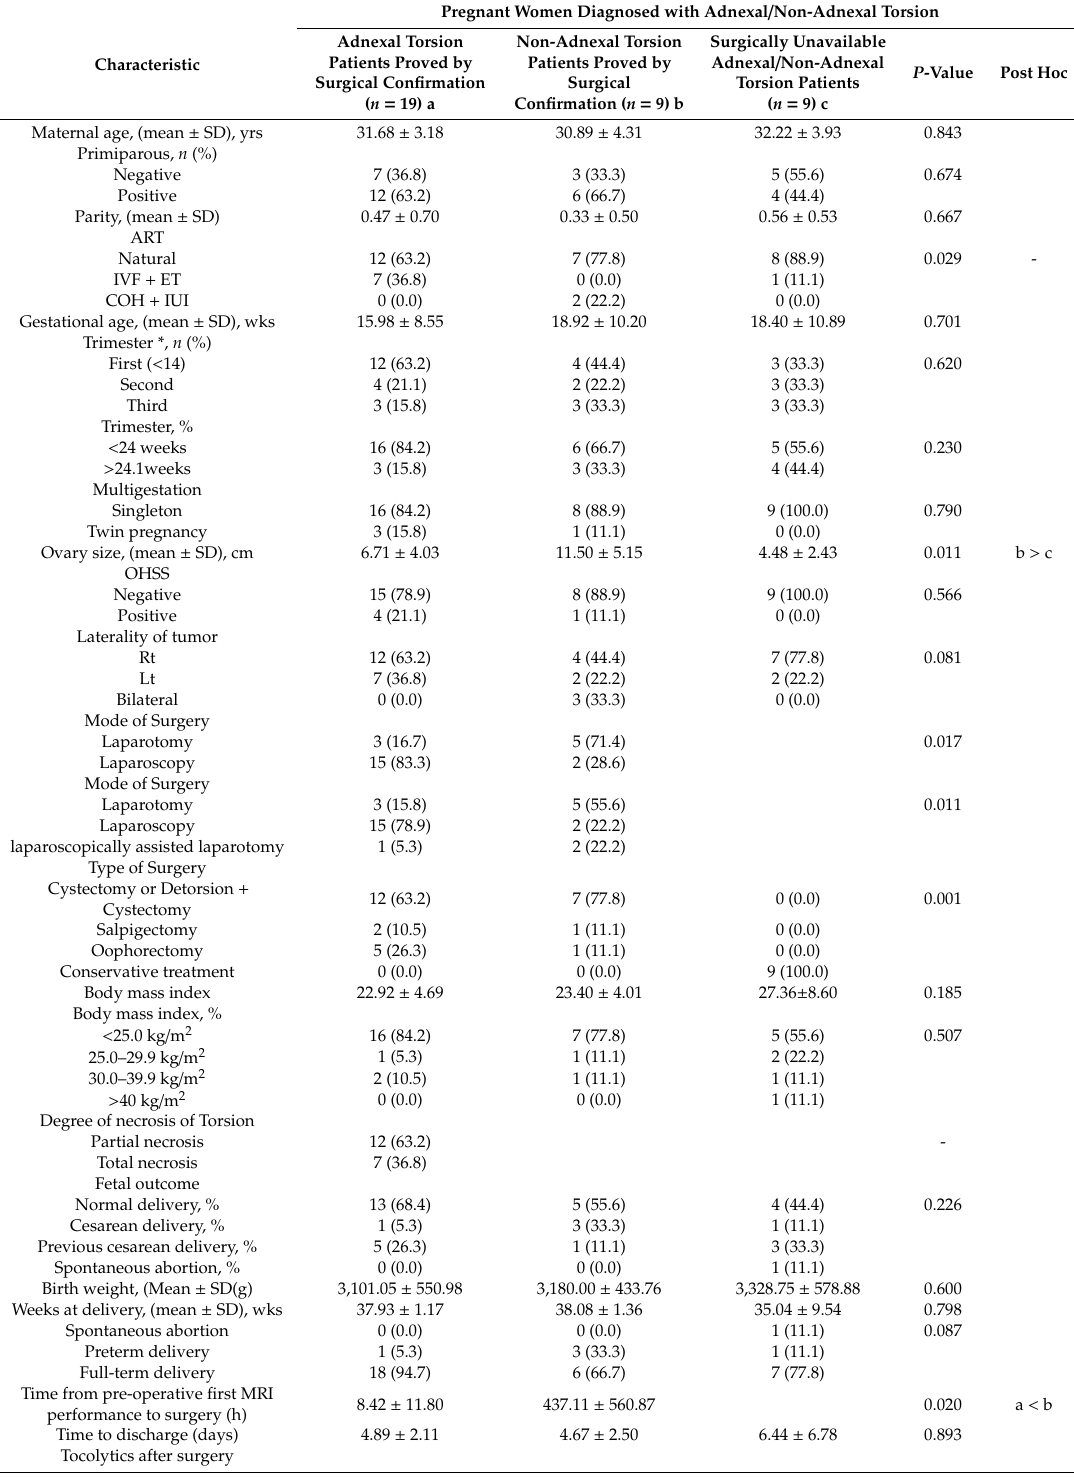
Table 1. Demographics of the participating pregnant